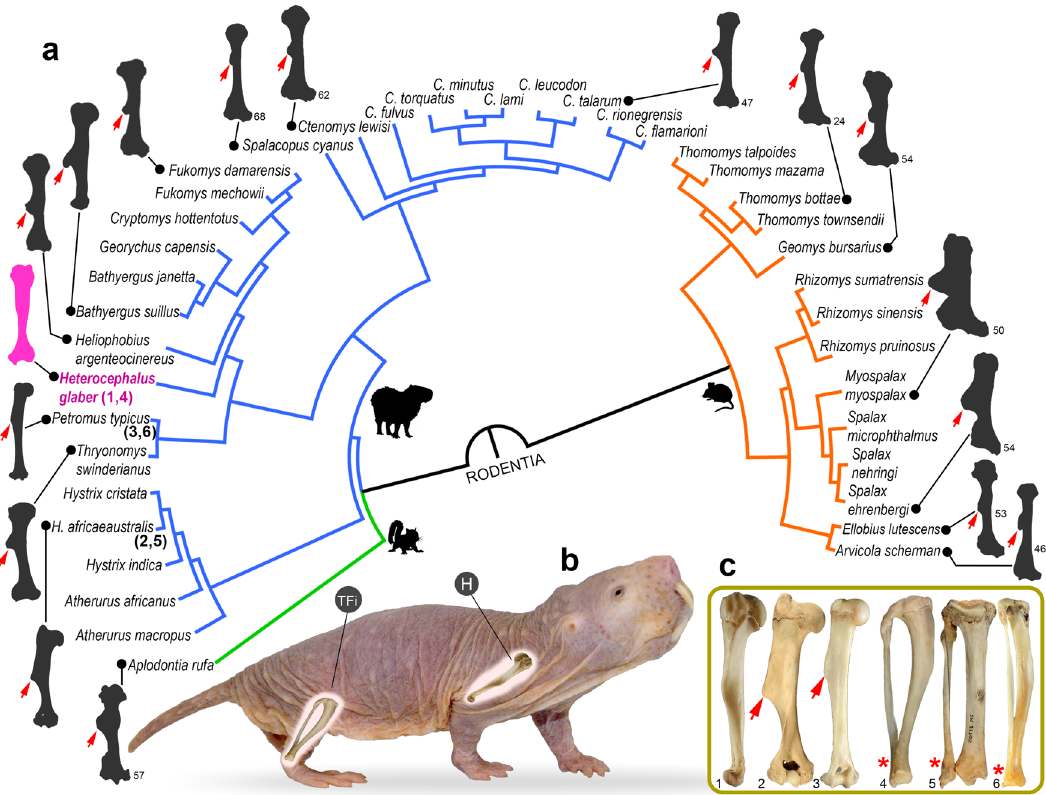
Fig. 6 The limb phenotype of Heterocephalus glaber compared with other fossorial mammals. a Phylogenetic relationships of 33 fossorial species from the three main rodent lineages illustrating the distinctiveness of the humerus of H. glaber (pink bone): Sciuromorpha (green branches), Hystricomorpha (blue branches), and Myomorpha (orange branches). Note the presence of a projected deltoid tuberosity (DT, red arrows) in all subterranean taxa, except in H. glaber where it is highly reduced (see details in Supplementary Table 6). Bones silhouettes not to scale. The bone silhouettes extracted and modi fi ed from other sources are indicated by a reference number (see details in Supplementary References). b Anatomical disposition of the humerus (H) and tibia- fi bula (T-Fi) in H. glaber . Note the poor development of claws in the pes and manus in this species. c Comparison of the humerus (1,2,3), tibia and fi bula (4,5,6) of H. glaber (1,4) and the non-subterranean outgroups, Hystrix africaeaustralis (Hystricidae) (2,5) and Petromus typicus (Petromuridae) (3,6). Note the presence of a projected DT in the closer relatives of Bathyergidae (2,3), the poor development of this feature in H. glaber , and the unfused condition (*) of the distal tibia and fi bula in all taxa (4-6). Bones not to scale. Phylogenetic relationships obtained from www.vertlife.org 79